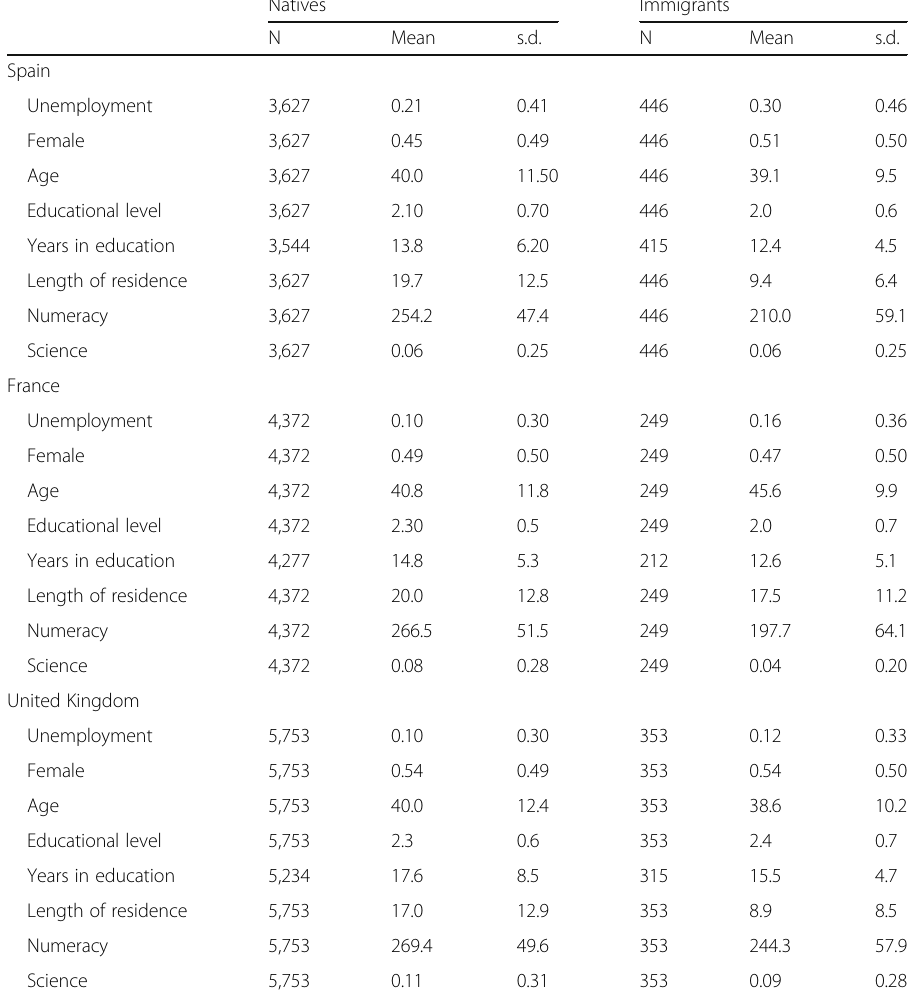
Table 1 Summary of sample sizes by migrant status and distribution of variables used in the analyses Natives Immigrants N Mean s.d. N Mean s.d. Spain Unemployment